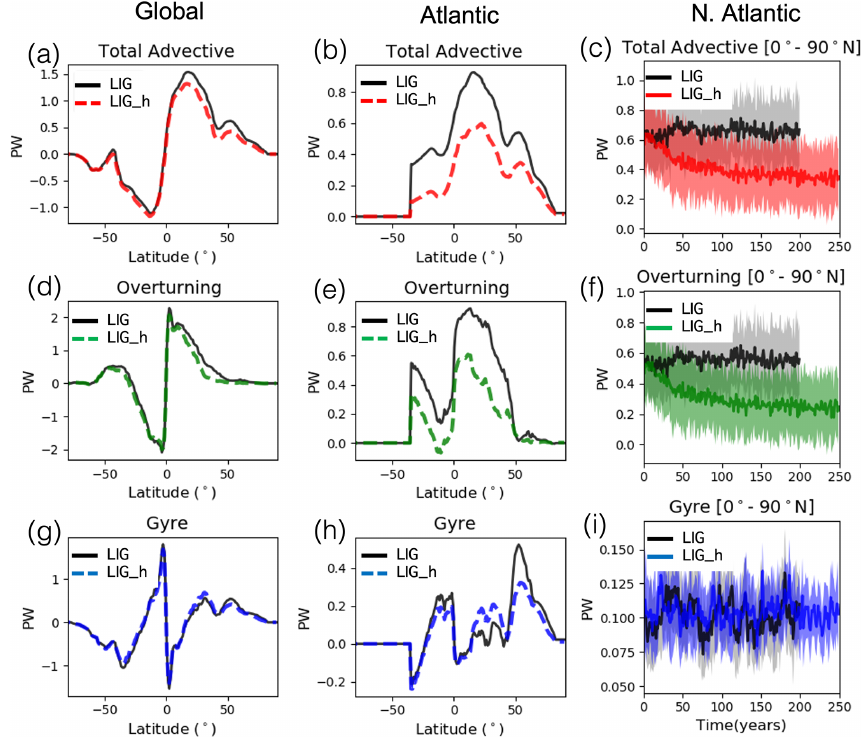
Figure 9. Total advective (a–c) , overturning (d–f) , and gyre (g–i) northward heat transport for the global basin (a, d, g) , the whole Atlantic basin (b, e, h) , and the North Atlantic basin only (c, f, i) for the LIG_hosing and LIG simulations. Panels (a) , (b) , (d) , (e) , (g) , and (h) show zonal means computed over the long-term means. Panels (c) , (f) , and (i) show area-weighted annual time